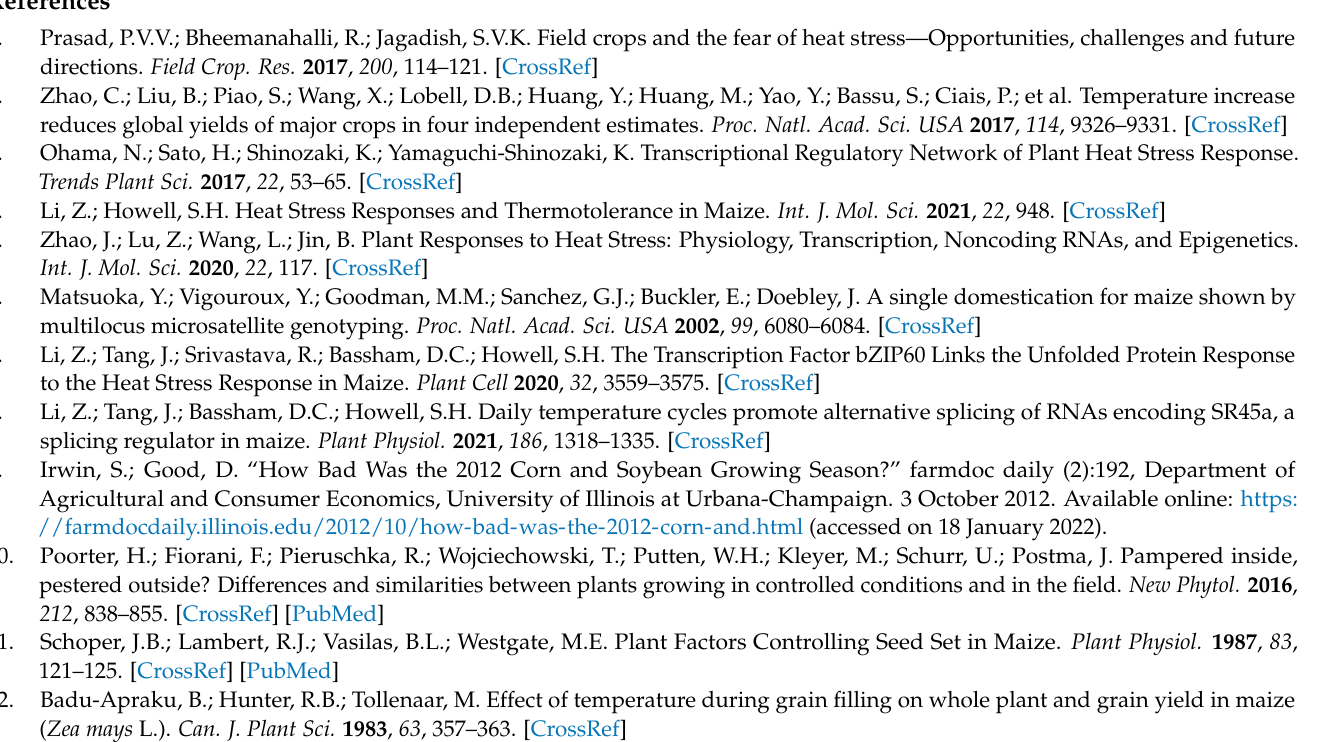
maize vegetative growth and reproduction (June, July, and August) in Ames, Haerbin, and Tieling. Figure S2: Violin plots shows the maximum daily temperature during maize vegetative growth and reproduction (June, July, and August) in six typical cities in the Chinese maize production region and the US corn belt. Figure S3: The maximum temperature during maize vegetative growth and reproduction (June, July, and August) in Jinan, Shijiazhuang, Zhengzhou, Ames, Haerbin, and